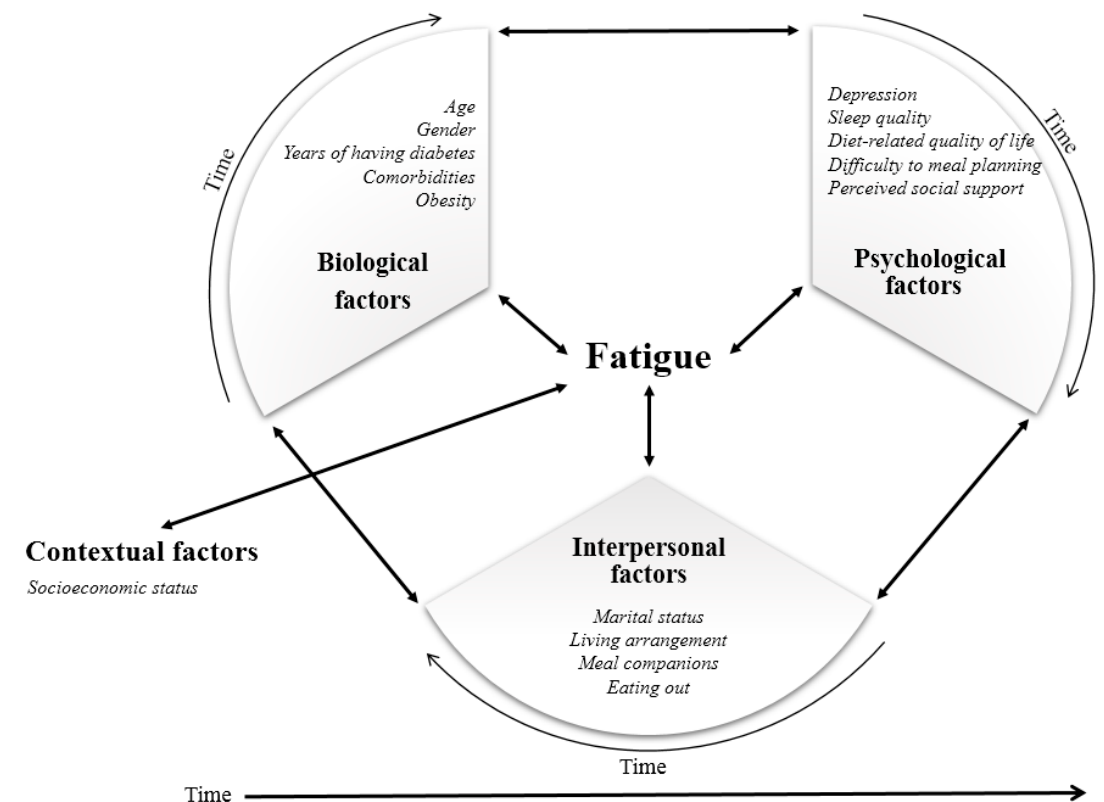
Figure 1. Conceptual framework of dynamic biopsychosocial determinants for fatigue.